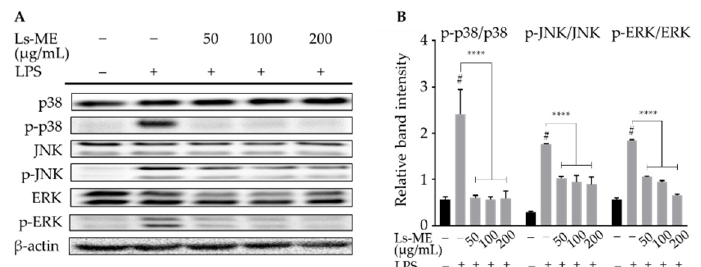
Figure 5. The inhibitory activity of Ls-ME on LPS-induced phosphorylation of MAPKs signaling pathway in RAW 264.7 macrophages. Cells were cultured with serial concentrations of Ls-ME for 24 h, followed by treatment with LPS (1 µ g / mL) for 18 h. The expression of total p38, JNK, ERK 1 / 2 , and phosphorylated p-p38, p-JNK, p-ERK 1 / 2 were examined using Western blot analysis ( A ). Relative band intensities were analyzed using Image J ( B ). Data of the three replicates are represented as mean ± SD. # p < 0.05 is expressed in comparison with cells incubated alone; **** p < 0.0001 is expressed in comparison with LPS treatment only.